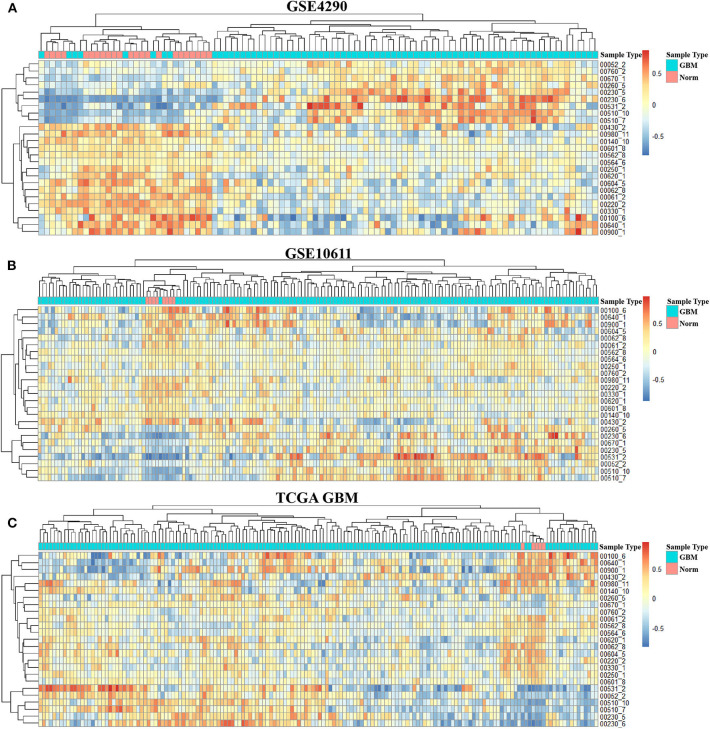
Activity score heat map of GBM-related metabolic subpathways in the activity score matrix of GSE4290 (A), GSE10611 (B), and GDC TCGA Glioblastoma (C).